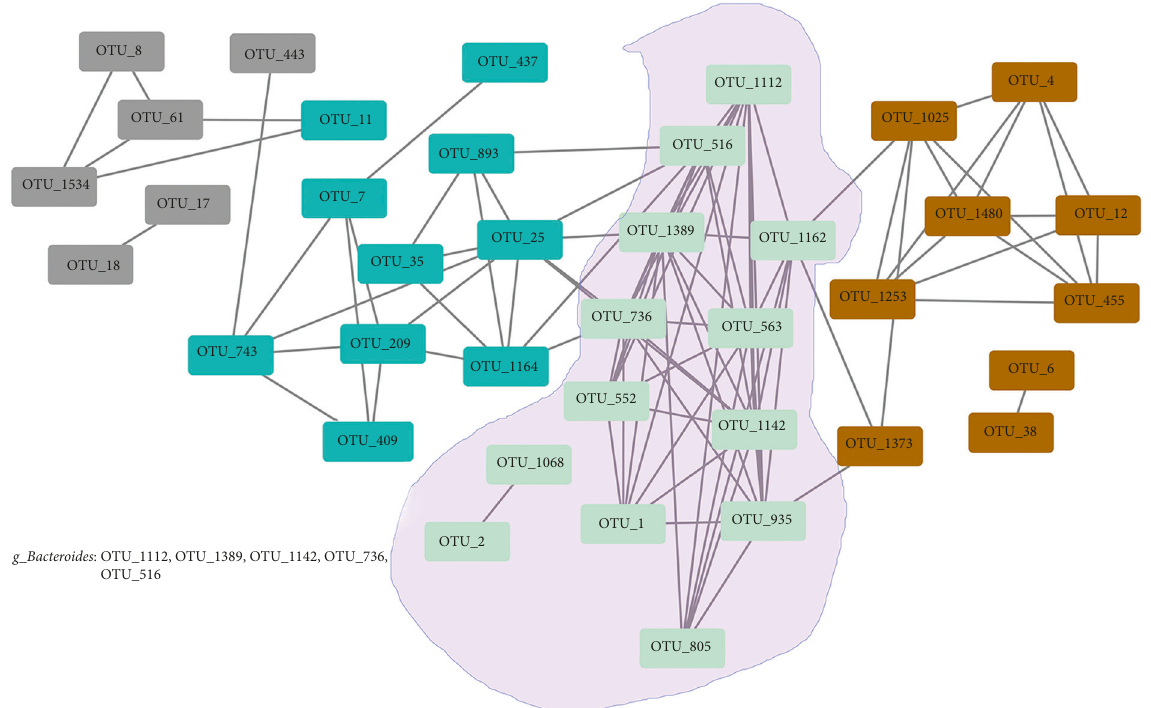
Figure 4: Network obtained by WGCNA. In this graph, the isolated nodes are removed from the network. Four modules, named MEgrey, MEturquoise, MEblue, and MEbrown, include 6, 13, 10, and 9 OTUs, respectively. The important module, MEturquoise, is highlighted with purple shadows. In MEturquoise, OTU_1112, OTU_1389, OTU_1142, OTU_736, and OTU_516 all represent g_Bacteroides .